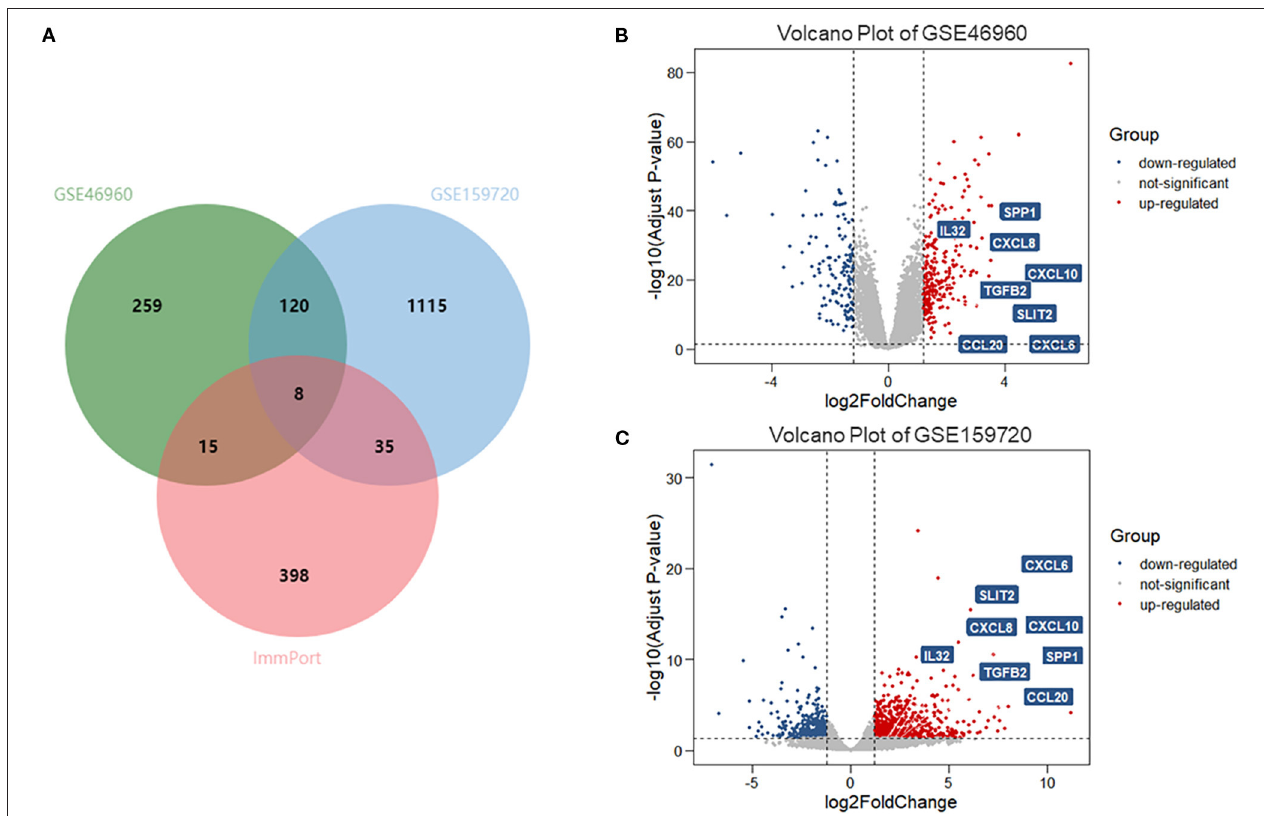
FIGURE 1 | DEGs and immune-related genes in GSE46960 and GSE159720. (A) One hundred twenty-eight DEGs were duplicated in GSE46960 and GSE159720, among which eight DEGs were included in ImmPort. (B,C) Volcano plot of GSE46960 and GSE159720. The eight immune-related genes are highlighted. DEGs: differentially expressed